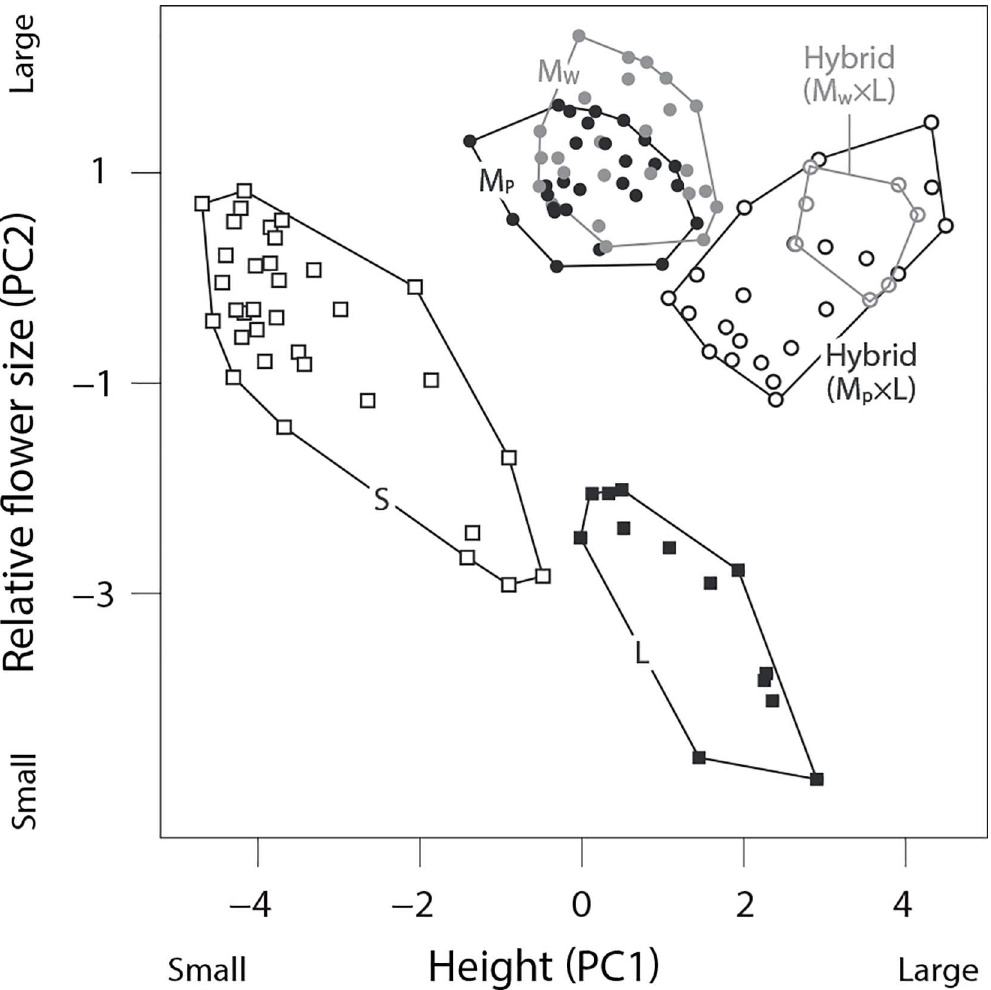
Fig 3. The results of the principal component analysis on morphological traits of the three species and the hybrid between the M- and L-species. PC1 and PC2 were mainly characterized by body size and relative flower size, respectively. M P : purple morph of M-species, M W : white morph of M-species, S: S-species, L: L-species. Total number of individualsof each species/morph tested is as follow; S: 34, M P : 27, M W :25, L: 13, hybrid (M P × L): 22, hybrid (M W × L):